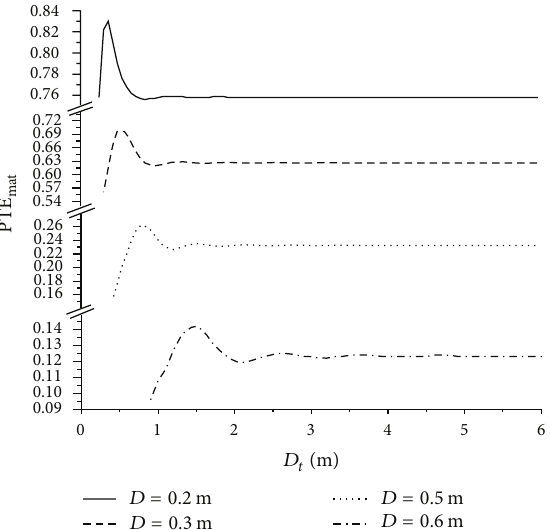
Figure 7: Efficiency of retriever-based WPT system at frequency shown in Figure 6 against 𝐷 𝑡 for different 𝐷